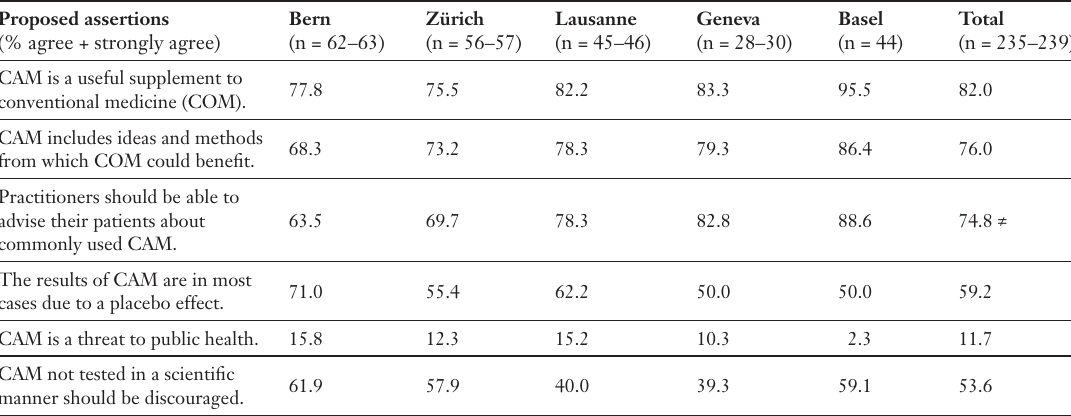
Students’ attitude toward CAM.